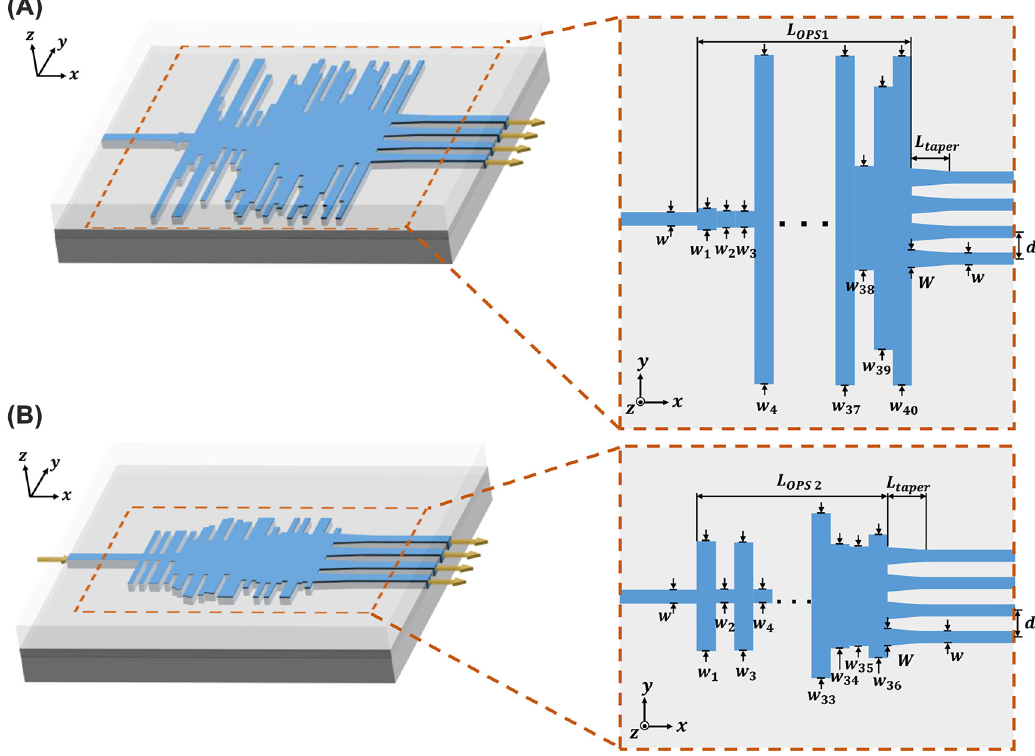
Figure 2: Schematic of the designs (A) OPS 1 and (B) OPS